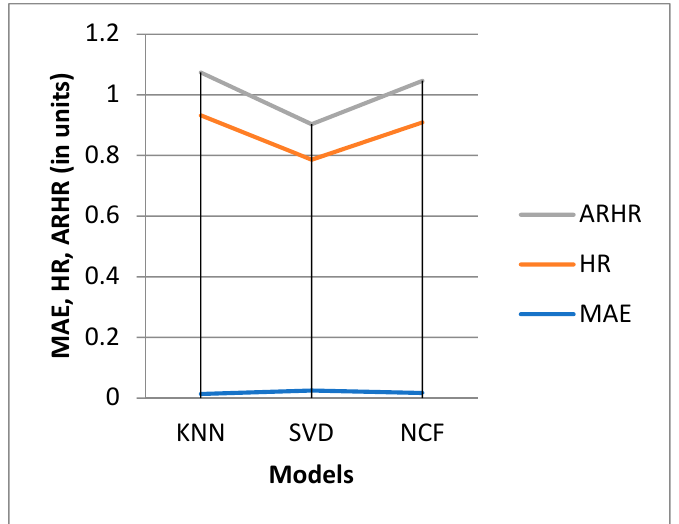
Figure 12. Comparative performance results of different models in terms of MAE, HR and ARHR in 70:30 training–testing scenario. Table 3. Performance evaluation of different models (in units) in 80:20 training–testing ratio.